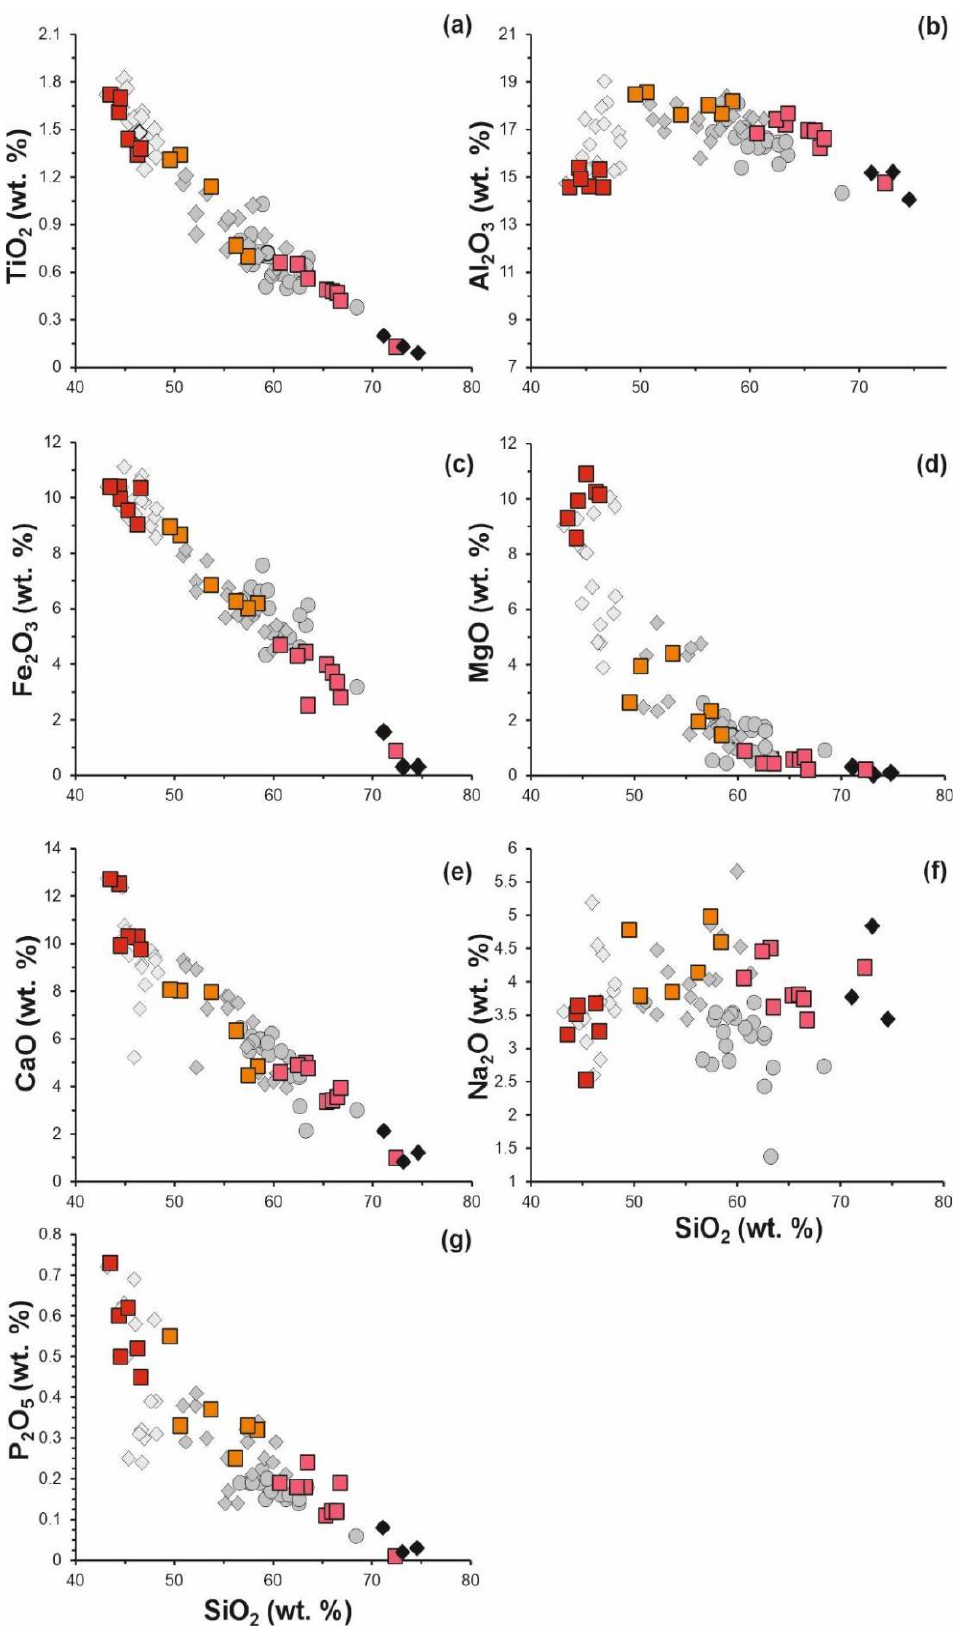
Figure 8. ( a – g ) Harker major oxide diagrams of SNV (The symbols as Figure 7).